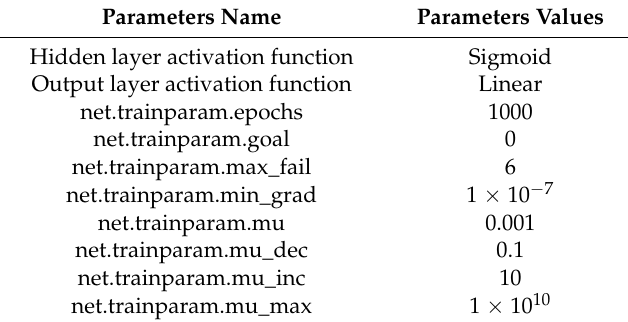
Table 2. ANN training parameters.